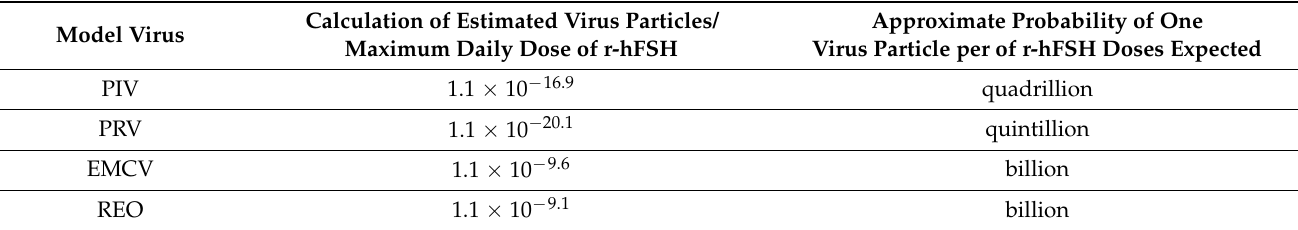
Table 4. Estimation of viral particles in finished product. Model